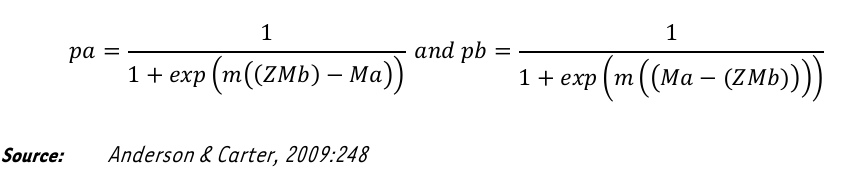
Data used to analyse the Conflict Success Function (CSF) in the Logistics